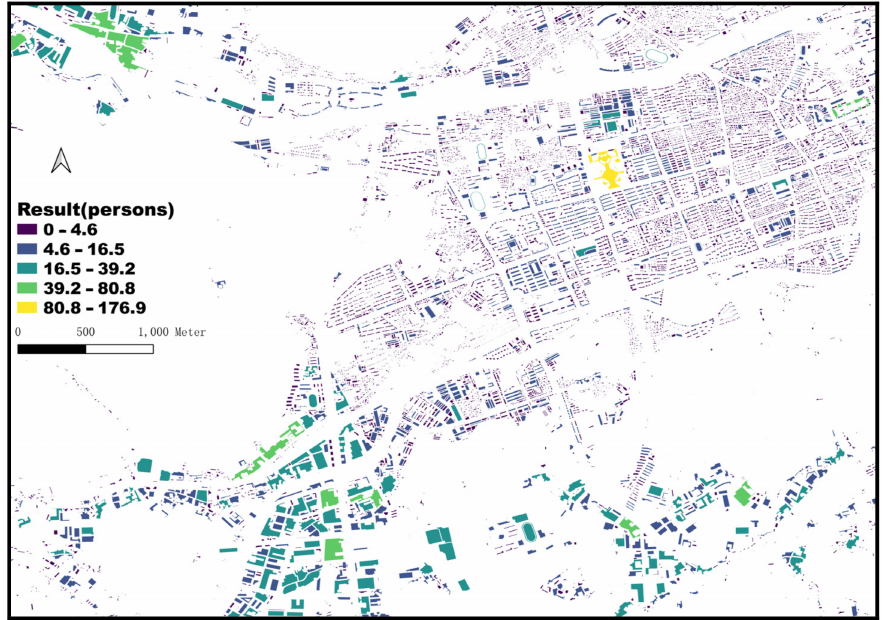
Figure 8. Results of the ML model.